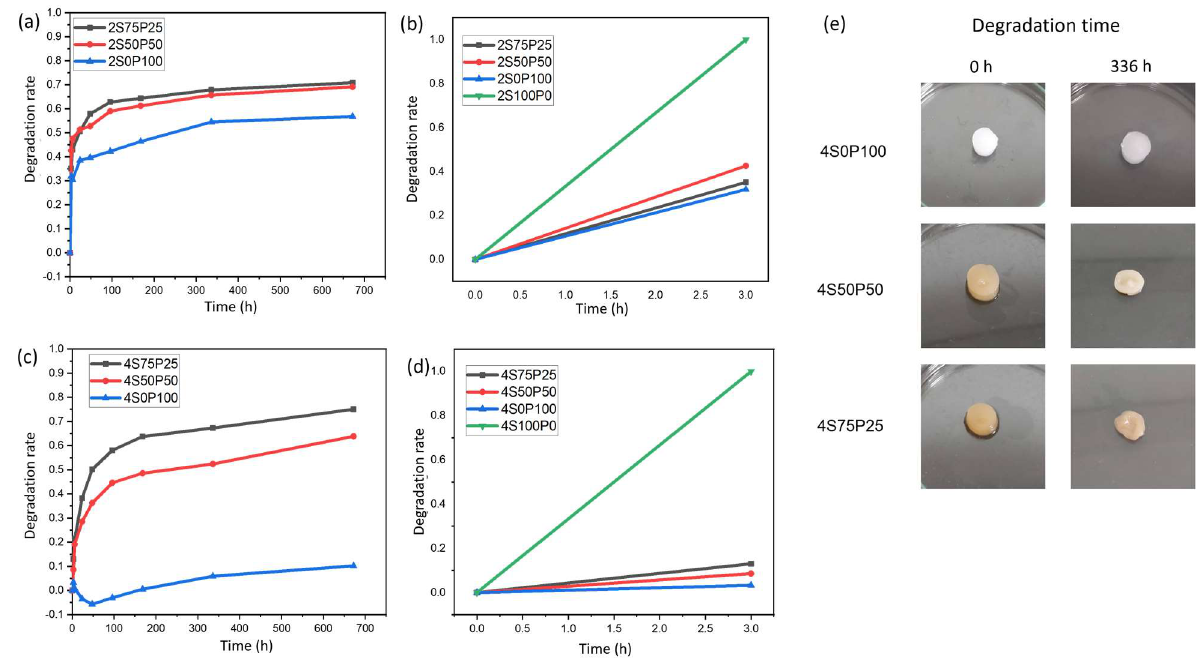
Figure 6. Hydrogel degradation rate after 672 h and initial 3 h for samples with a concentration of ( a , b ) 2% and ( c , d ) 4%. ( e ) Visual data of 4% hydrogel sample before and after 336 h degradation test.